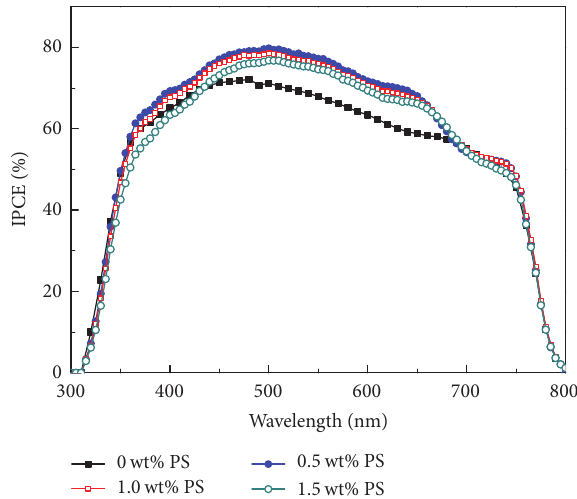
Figure 9: IPCE spectra of the best-performing solar cells based on different mass fractions of PS